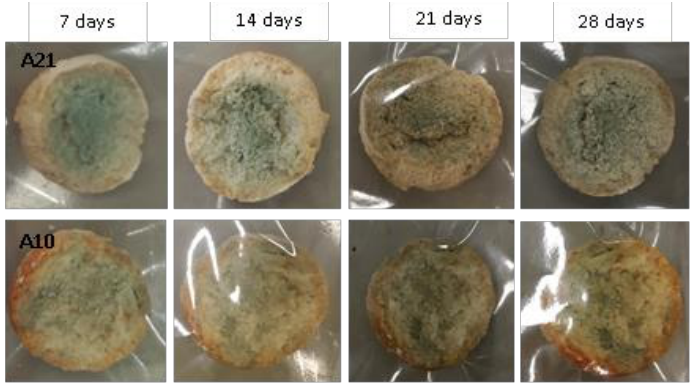
Figure 12. Examples of bread made from sourdoughs inoculated with the dual combination of isolates A21 and A10, and then artificially contaminated with Penicillium chrysogenum and incubated at room temperature for 7, 14, 21, and 28 days.